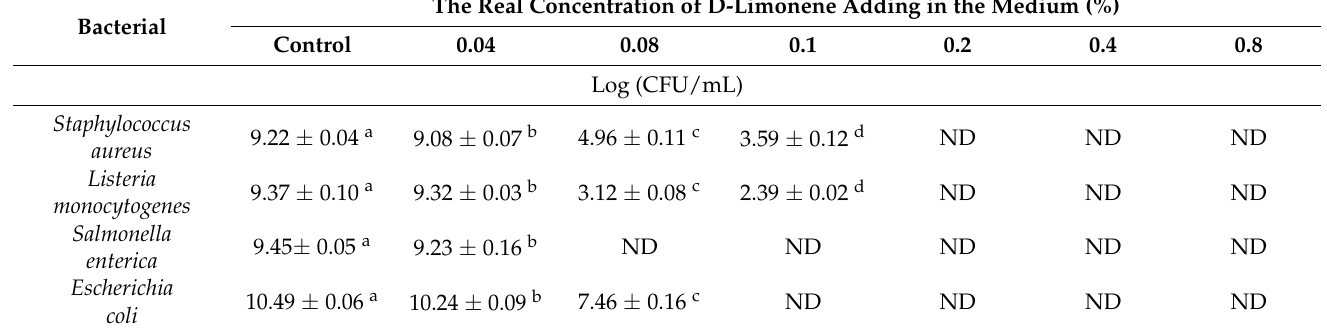
Table 2. Determination of the antibacterial activity of the D-limonene nanoemulsion against food- borne pathogens using broth dilution method.